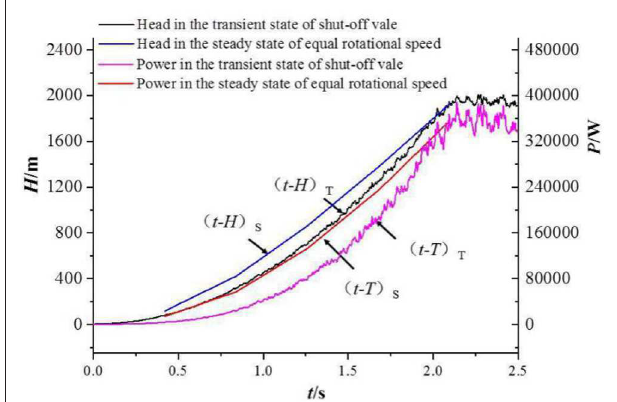
FIGURE 5 | Comparison of the pump characteristics between the start-up process of the closed-valve transition and the steady state of the same speed. Subscript S indicates steady state and subscript T represents transient state.